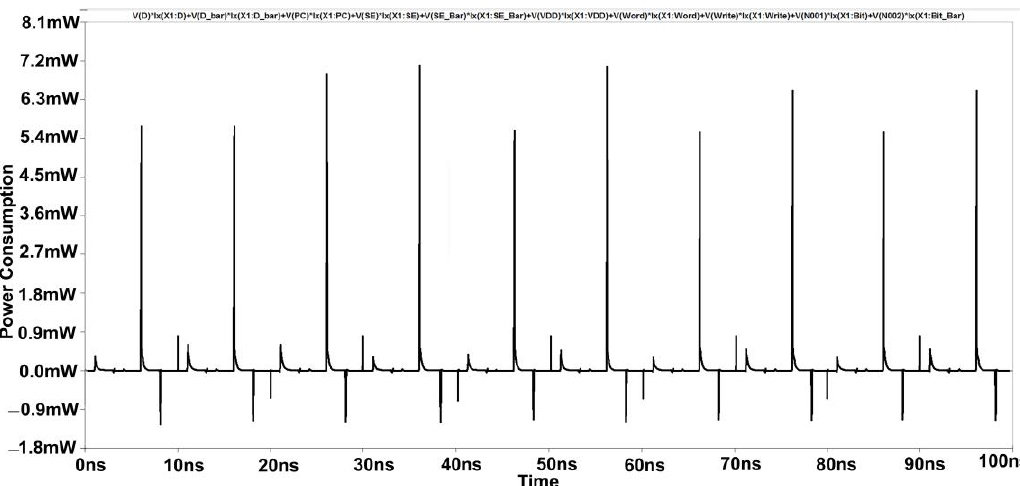
Figure 13. Power Consumption Spectrum of Modified Basic Latch Sense Amplifier.